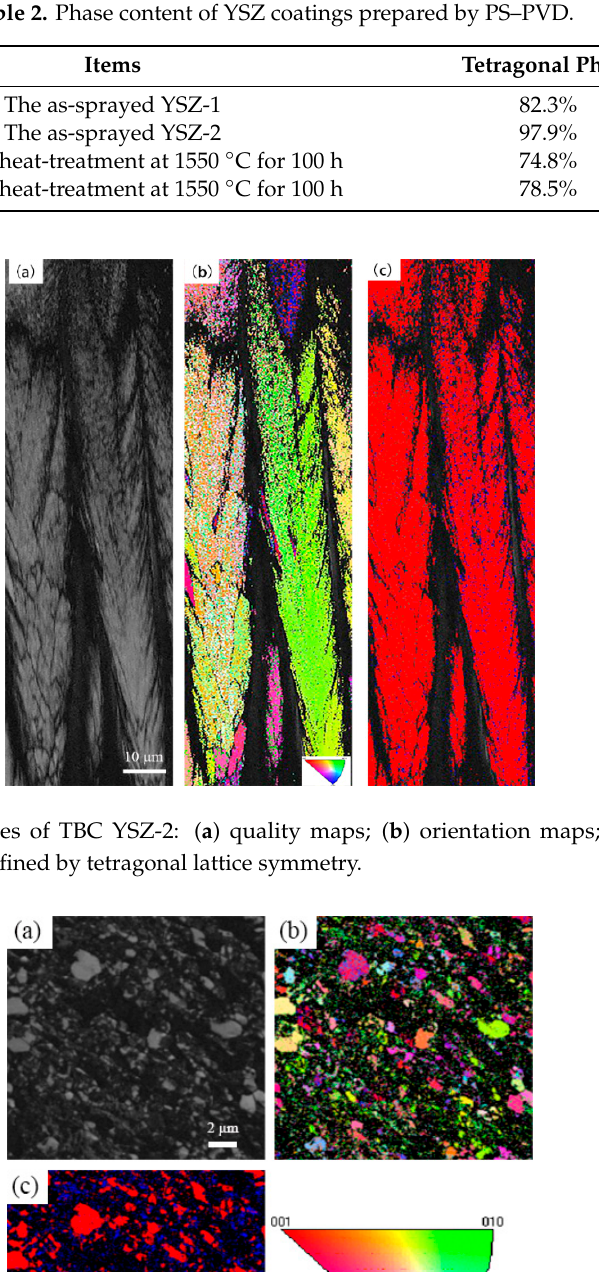
Figure 7. EBSD images of TBC YSZ-1 after heat treatment at 1550 °C/100 h: ( a ) quality maps; ( b ) orientation maps; ( c ) phase maps; The orientations are defined by tetragonal lattice symmetry.